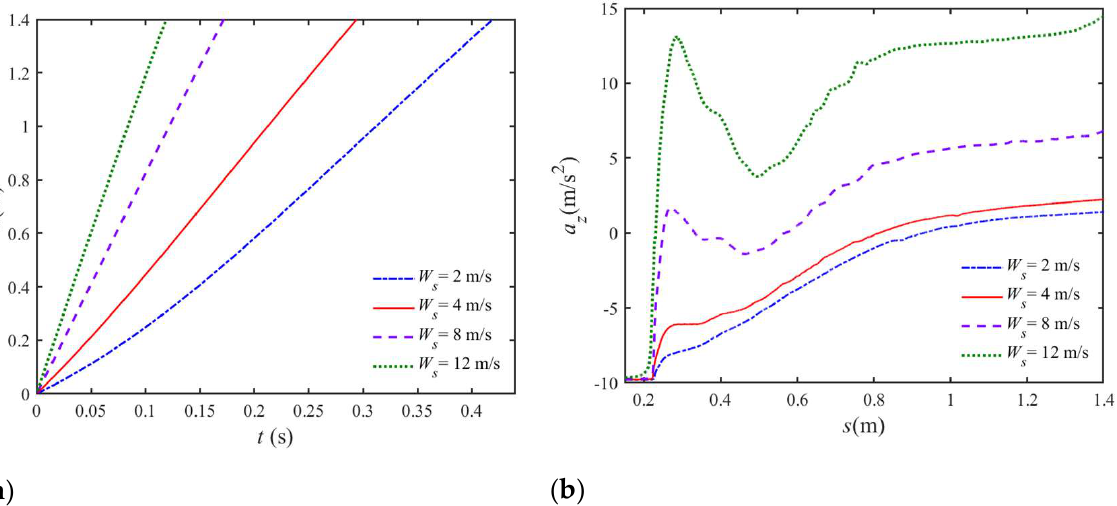
Figure 11. Comparison of the depth curve of ( a ) vertical displacement and ( b ) vertical velocity for the water entry of UAUV with different initial velocities.